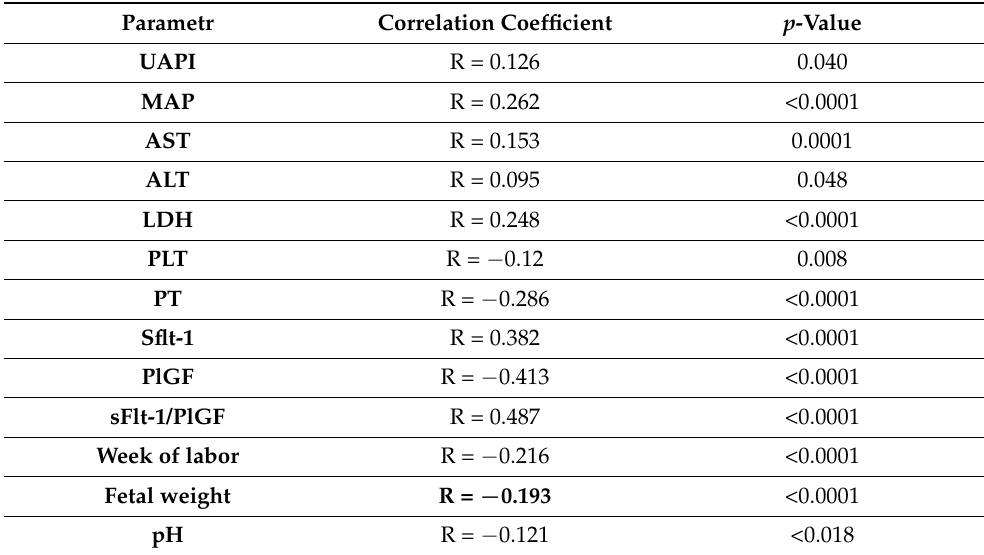
Table 4. Analysis of the correlations between uric acid levels and the evaluated parameters across the entire study group.